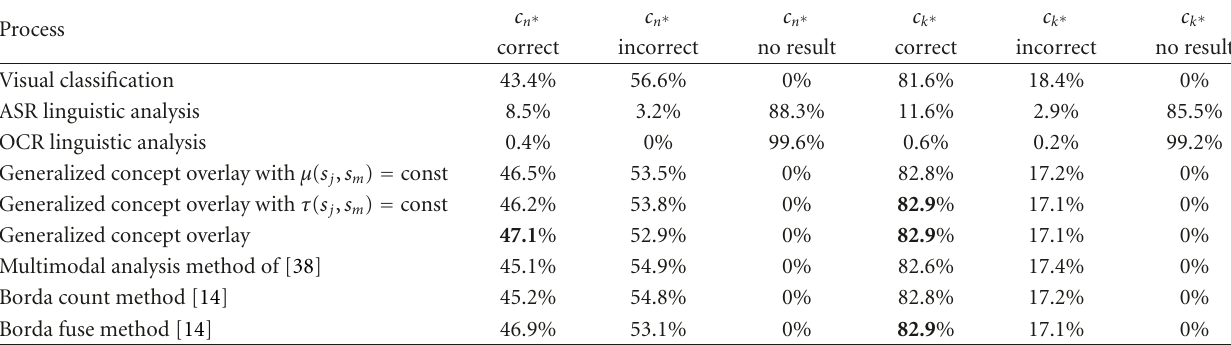
Table 2: Multimodal analysis results in the news domain—entire